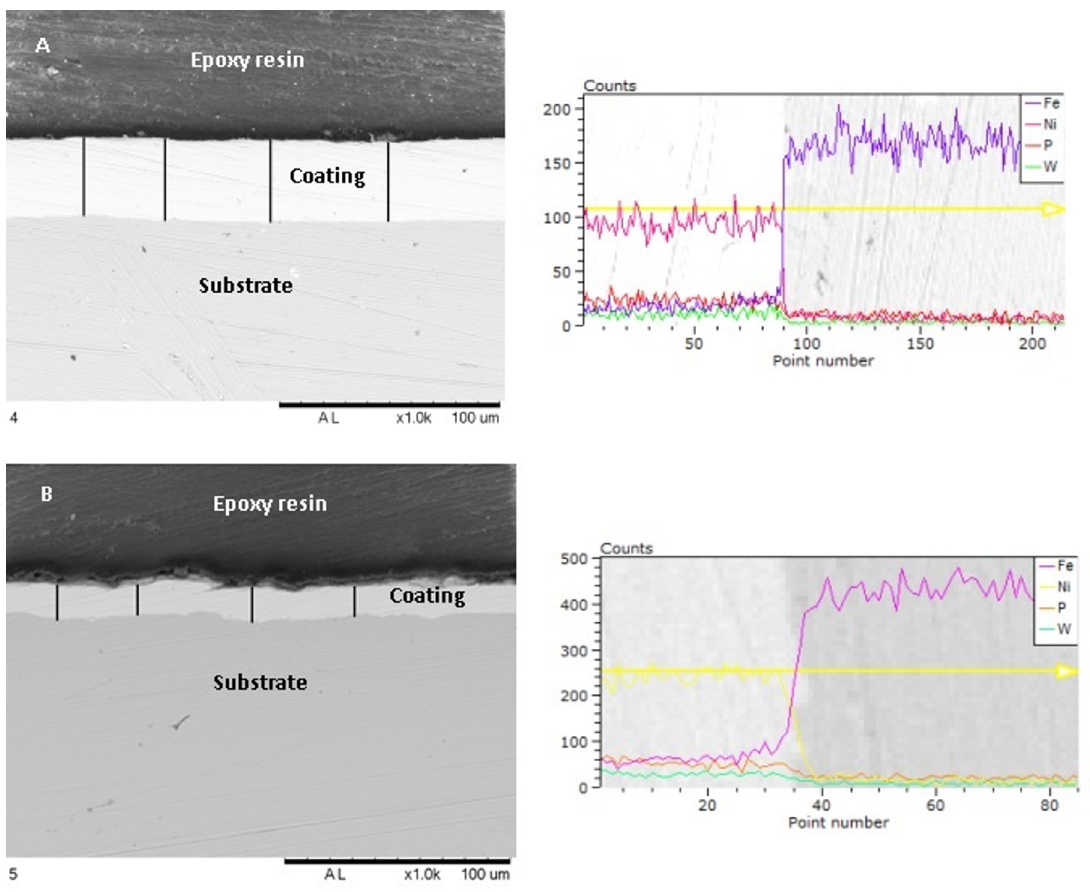
Figure 4. SEM micrographs of cross-sections of the coatings obtained in baths: d) 4 and e) 5. The corresponding EDS linescans are shown at right.